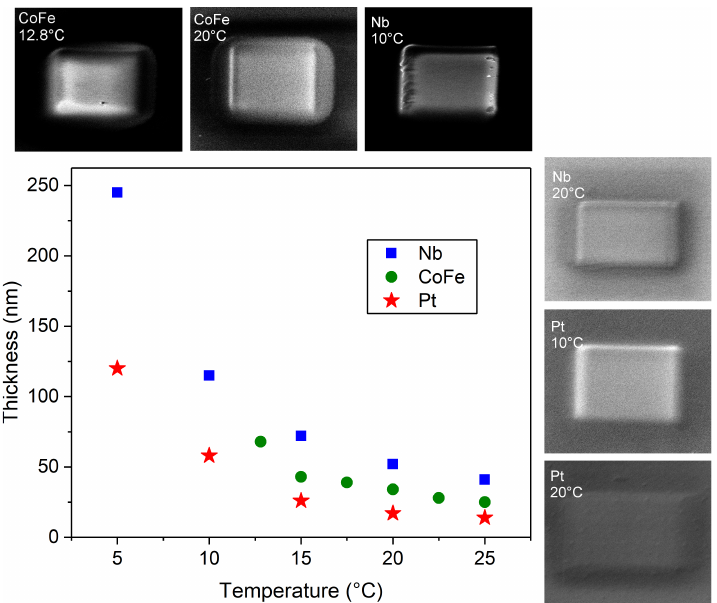
Figure 2. Thickness vs. temperature of samples grown at 5keV and 30pA beam current (experiment b ). Green points, blue squares, and red stars refer to samples grown using the CoFe-, Nb-, and Pt-precursor, respectively. Distributed about the main panel, a selection of SEM images is shown for samples fabricated at the substrate temperatures as